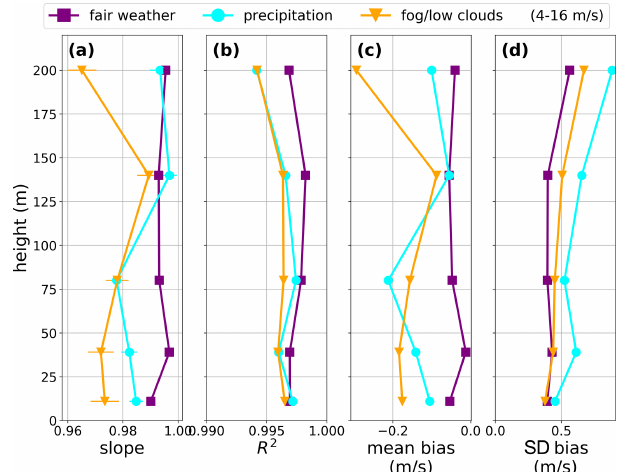
Figure 9. Profiles of linear regression analysis results and biases in the wind speed, applied to three different meteorological condi- tions: fair weather (purple squares), precipitation (cyan circles) and fog/low clouds (orange triangles). Here, wind speed is bounded to the 4–16ms − 1 range. Panels (a, b) show the parameters from a lin- ear regression (slope and R 2 ), and panels (c, d) show the mean bias and standard deviation of the bias. The error bars in panel (a) in- dicate the standard uncertainties of the parameter estimates (often behind the symbol).